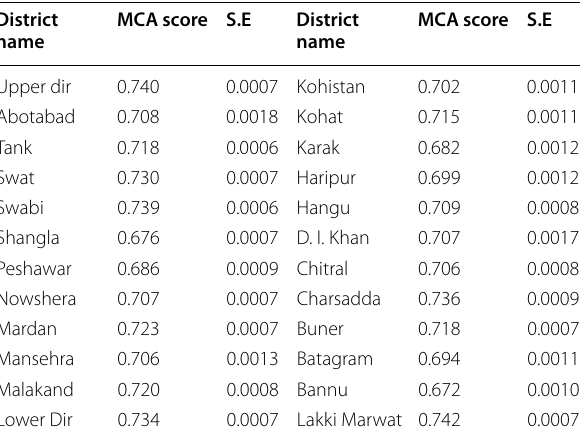
Table 7 Mean score of asset-based poverty index for districts of